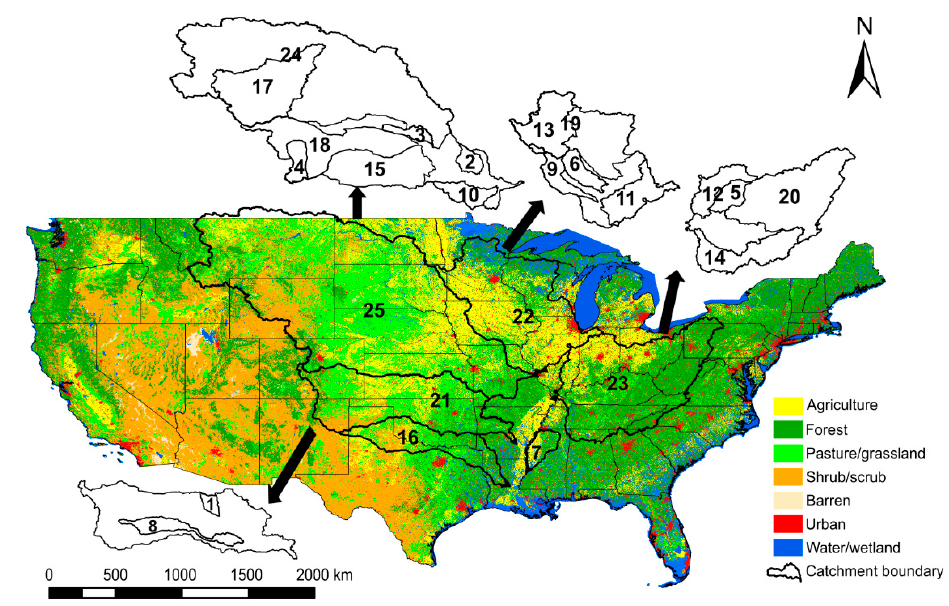
Figure 1. Study sites.